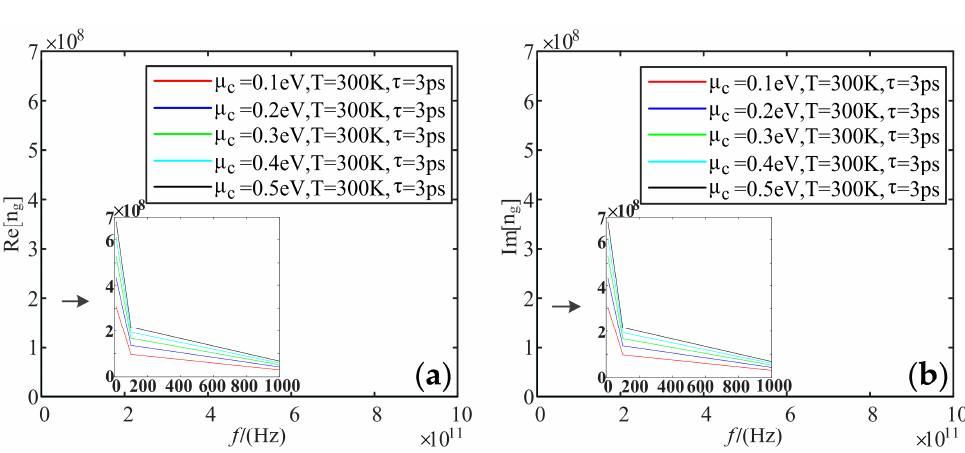
Figure 9. Variation curve of graphene dielectric constant with frequency at different relaxation times: ( a ) real part; ( b ) imaginary part.